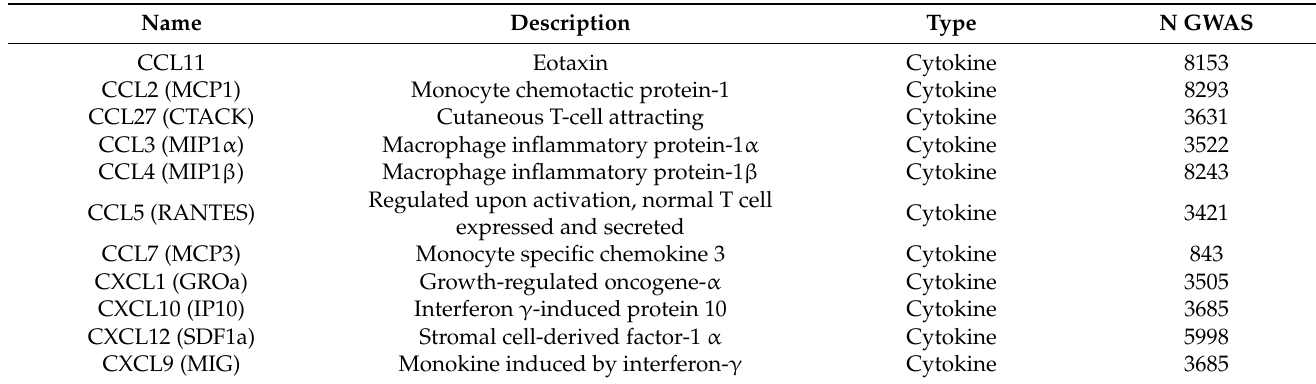
Table 1. GWAS summary statistics for the blood levels of 41 immune markers in the general population that were used in this study were obtained from the study by Ahola-Olli et al.